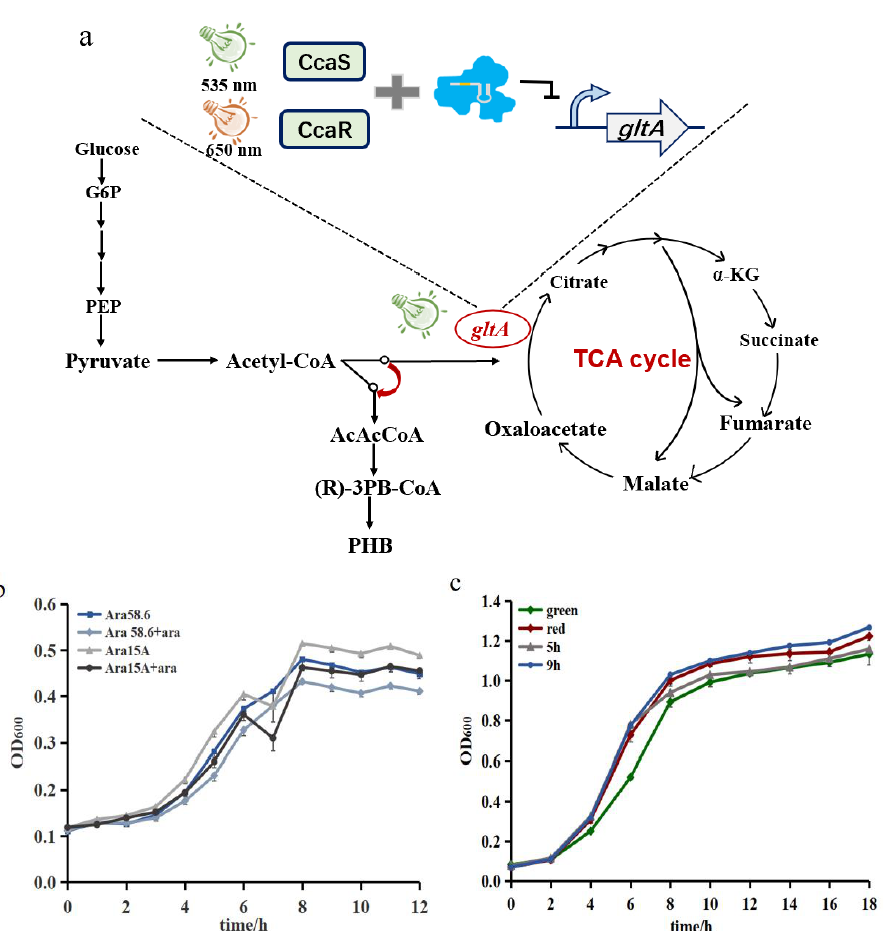
Figure 4. The regulation effect of the endogenous CRISPRi system targeting gltA . ( a ) The metabolic pathway to the synthetic product. Two acetyl-CoA will condense to produce acetoacetyl-CoA, which is catalyzed by acetoacetyl-CoA reductase to generate (R)-3-hydroxybutyryl-CoA. Then, it is polymerized by PHA polymerase to form PHB. ( b ) Comparison of the regulation effect between different plasmid copy numbers. Ara58.6 is the strain with the aracr58.6 plasmid, and Ara15A is the strain with the aracr15A plasmid. ( c ) The effect of different regulation times by switching red light to green light. Green and red represent continuous exposure to green and red light, respectively, whereas X h (X = 5.9) represents switching the light at X hours after starting the culture. Data represent the mean ± SD from three independent experiments ( n = 3).